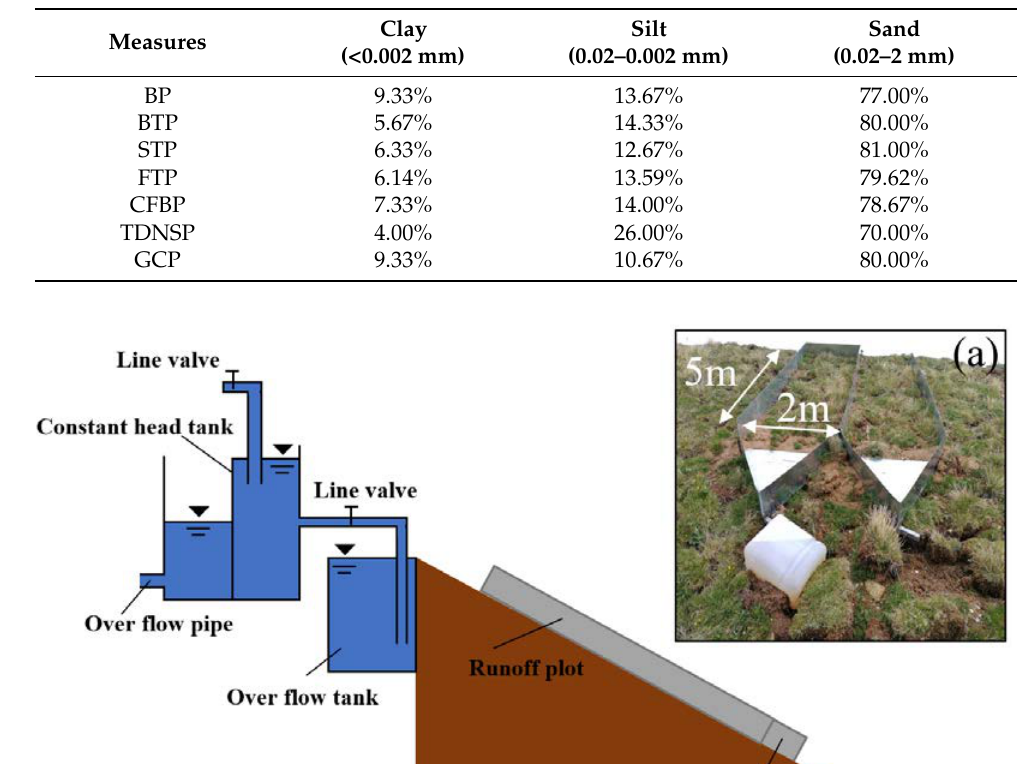
Table 1. Soil mechanical composition under different slope ecological protection measures.